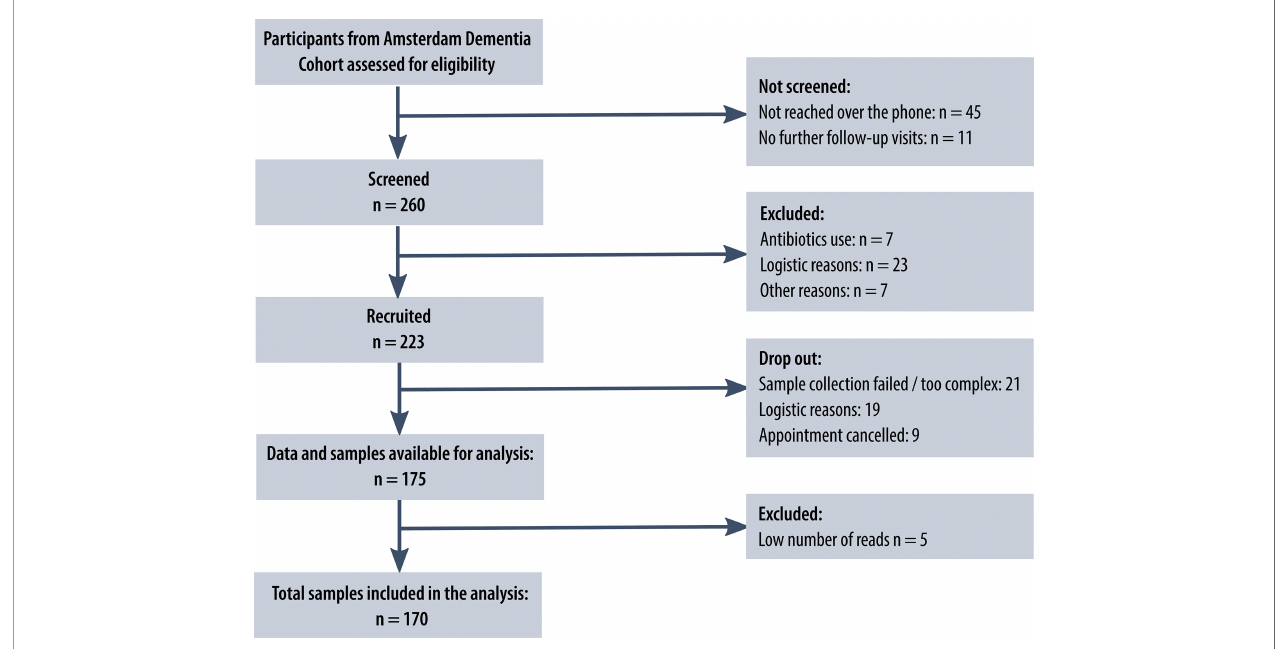
FIGURE 1 | Study fl owchart. Flowchart of the number of patients from the Amsterdam Dementia Cohort screened, recruited and included in the analysis, including reasons for exclusion at different stages. The fl owchart was designed following the ‘ Strengthening The Organization and Reporting of Microbiome Studies ’ (STORMS) checklist